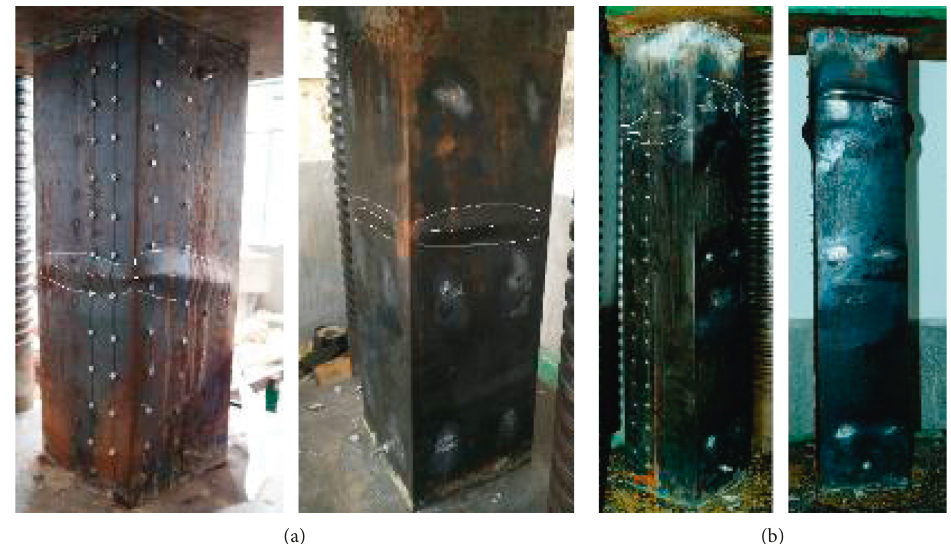
Figure 5: Failure modes of the specimens: (a) Z650; (b) Z1200.